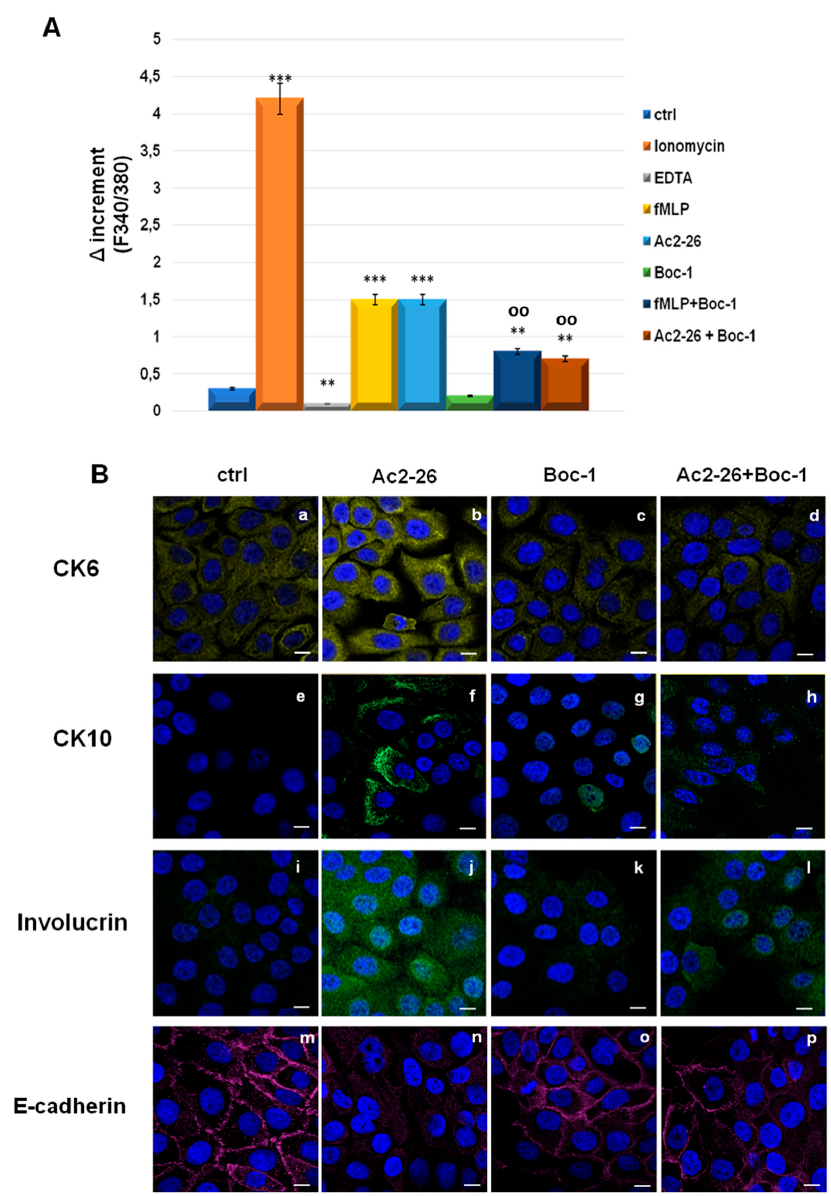
Figure 5. Effects of ionomycin (1mM), EDTA (15mM), fMLP (50nM), Ac-2-26 (1µM) and Boc-1 (100µM) on the Formyl Peptide Receptor (FPR)-induced rise in intracellular Ca 2+ in HaCaT cells. The histograms show the fluorescence ratio calculated as F340/F380 nm in absence of extracellular Ca 2+ . ( A ) Data are means ± SEM of three experiments with similar results. ** p < 0.01; *** p < 0.001 treated cells vs non treated control; oo p < 0.01 fMLP + Boc-1 and Ac2–26 + Boc-1 vs fMLP and Ac2–26, respectively. ( B ) Immunofluorescence analysis to detect: CK6 (panels a–d), CK10 (panels e–h), involucrin (panels i–l), E-cadherin (panels m-p) treated or not with Ac2–26 with or without Boc-1. Magnification 63 × 1.4 NA. Bar = 20 µm.